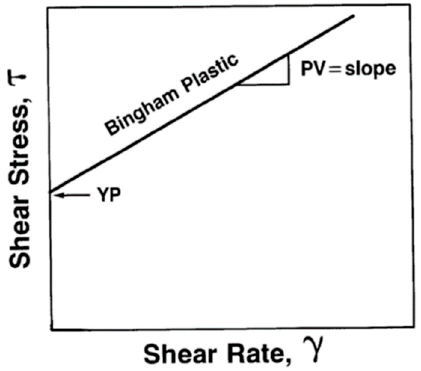
Figure 1. Bingham plastic model fluid behavior [30].